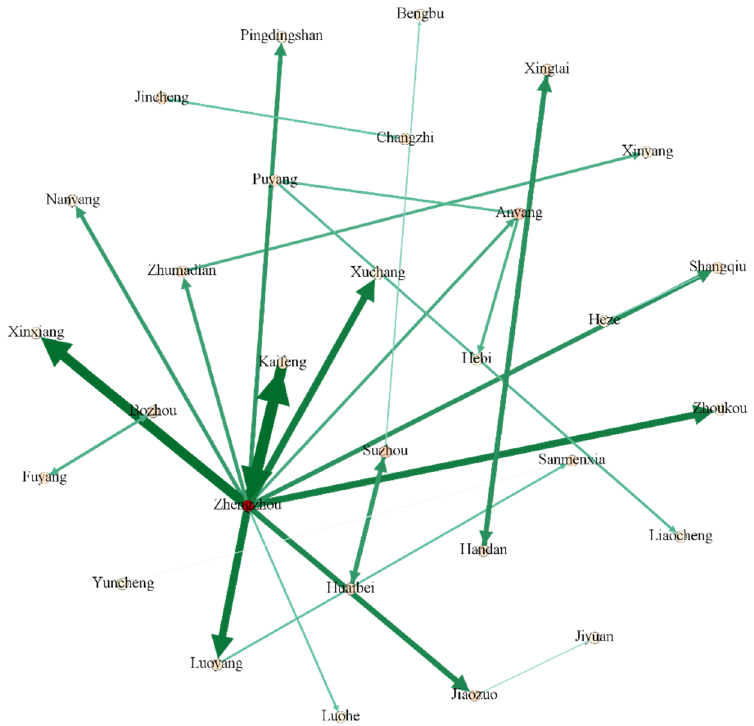
Figure 7. Cities of the largest scale of immigration to 30 cities.